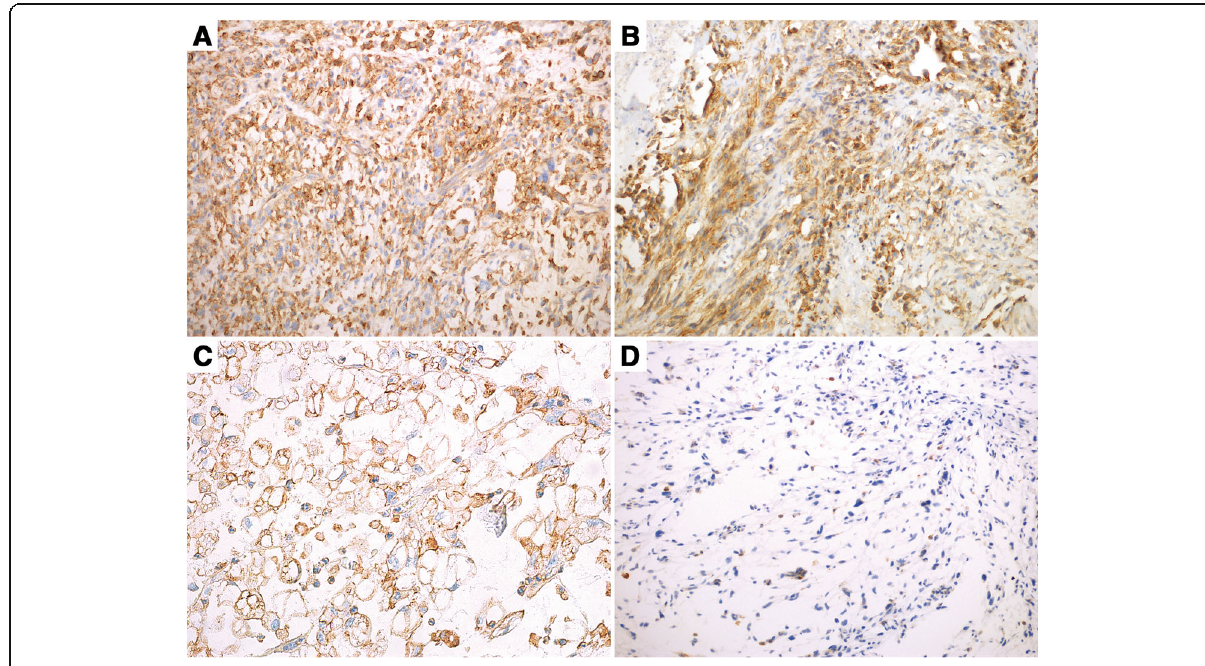
Fig. 2 MET immunostain shows positive cytoplasm staining in the FNCLCC Grade 2 ( a ), Grade 3 ( b ), and Epthelioid MFS ( c ), while negative expression in FNCLCC Grade 1 MFS ( d